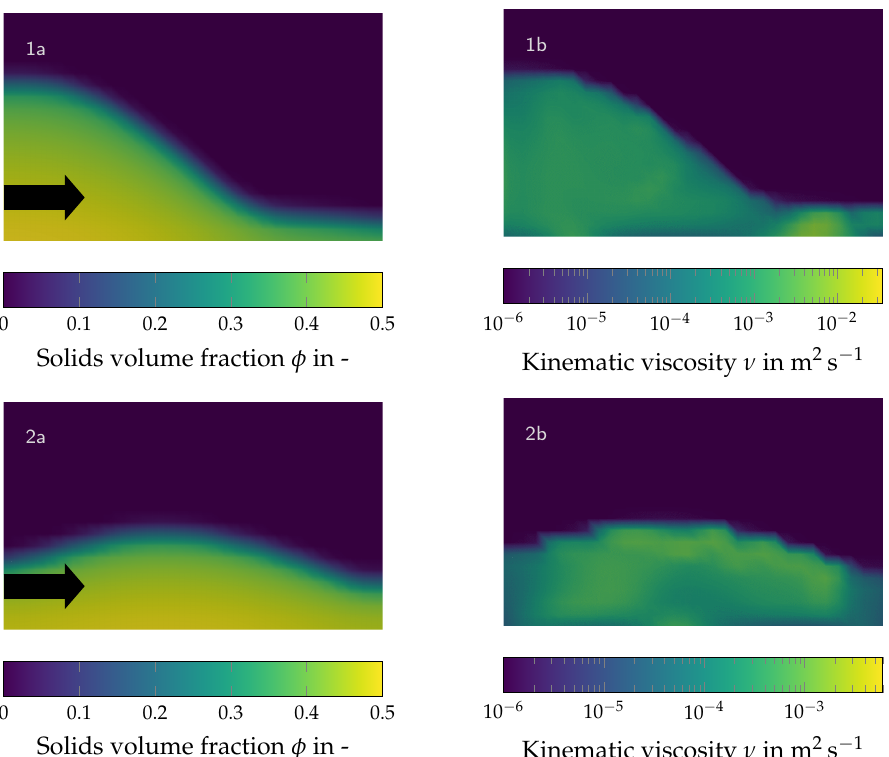
Figure 8. Characterization of a sediment with ( 1 ) and without ( 2 ) yield point in the screw channel: sediment distribution ( a ), kinematic viscosity ( b ). The evaluation was performed on the cut surface marked in blue in Figure 7. The screw flights are located on the right and left. The arrow indicates the direction of push due to the relative speed of the